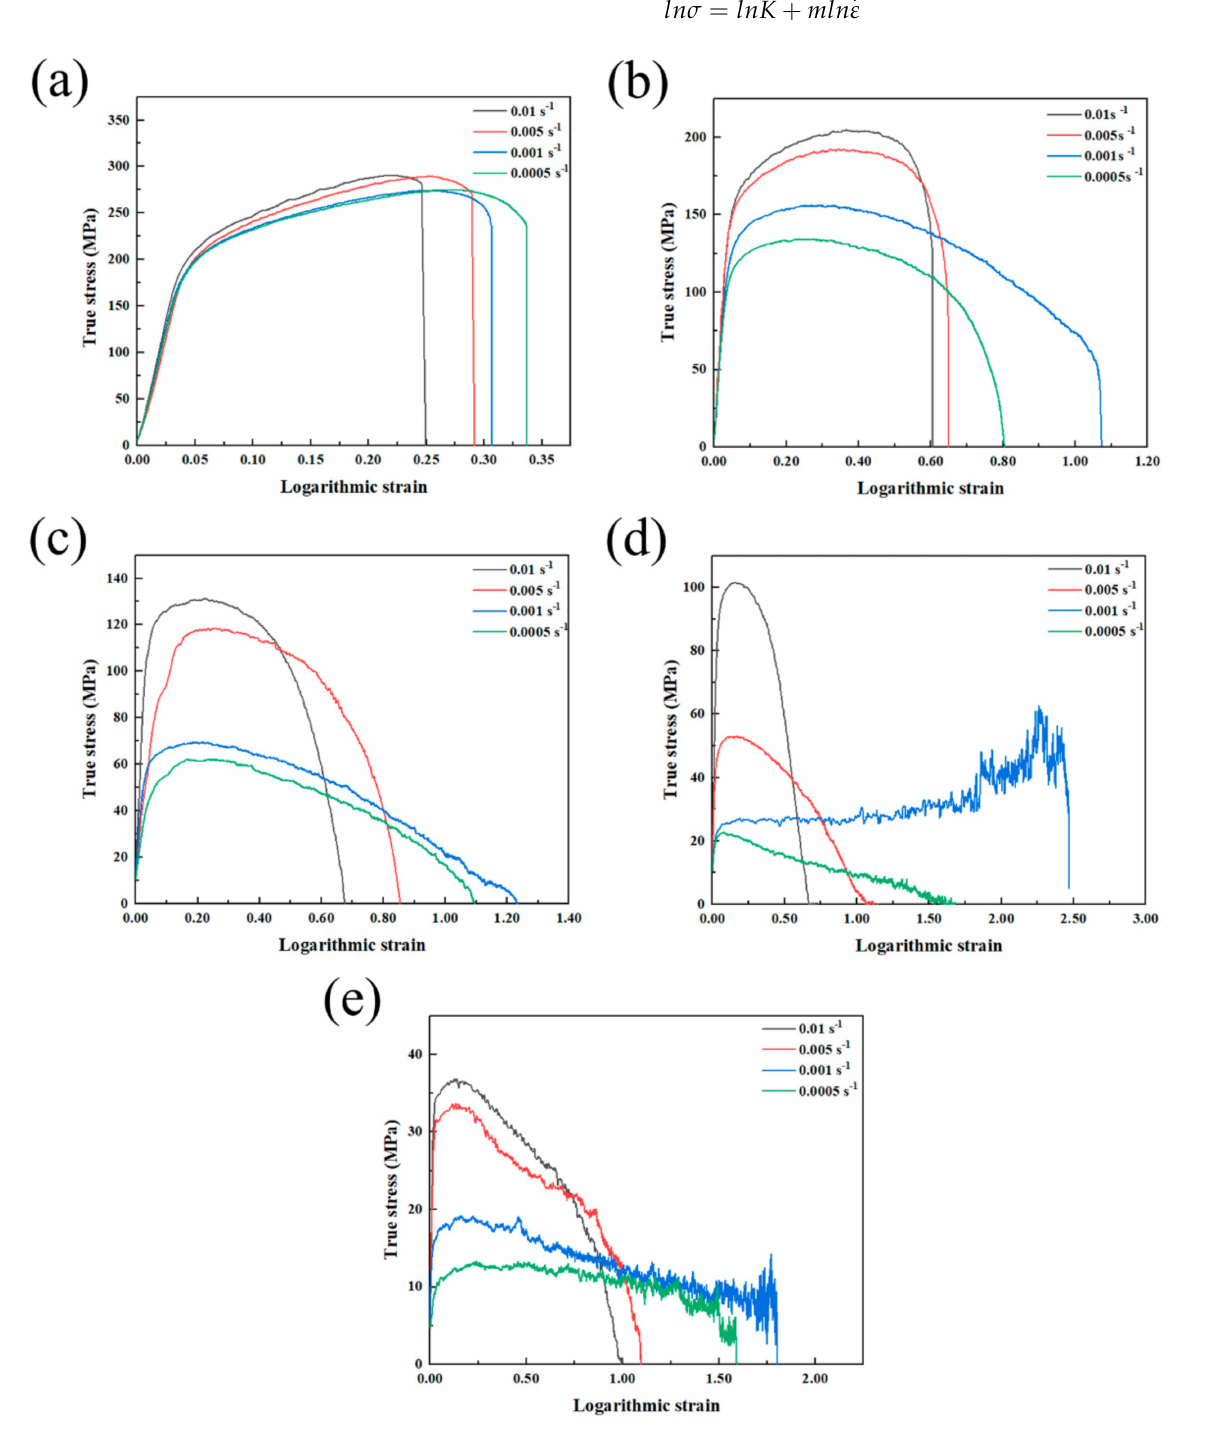
Figure 2. The true stress-logarithmic strain curves of Mg-Re alloys. ( a ) 250 ◦ C; ( b ) 300 ◦ C; ( c ) 350 ◦ C; ( d ) 400 ◦ C; ( e ) 450 ◦